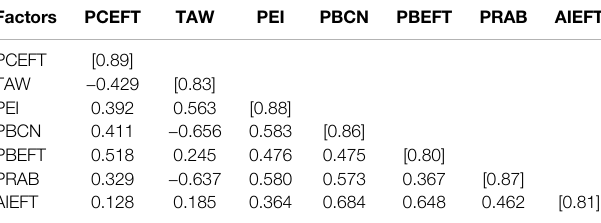
TABLE 2 | Discriminant validity based on (Fornell and Larcker, 1981). Factors